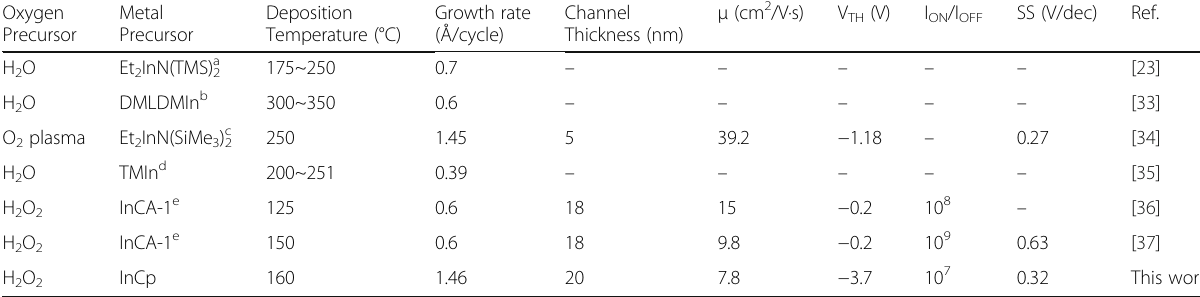
Table 2 Characteristics of the ALD In 2 O 3 Films and In 2 O 3 TFTs From Different Groups Oxygen Precursor